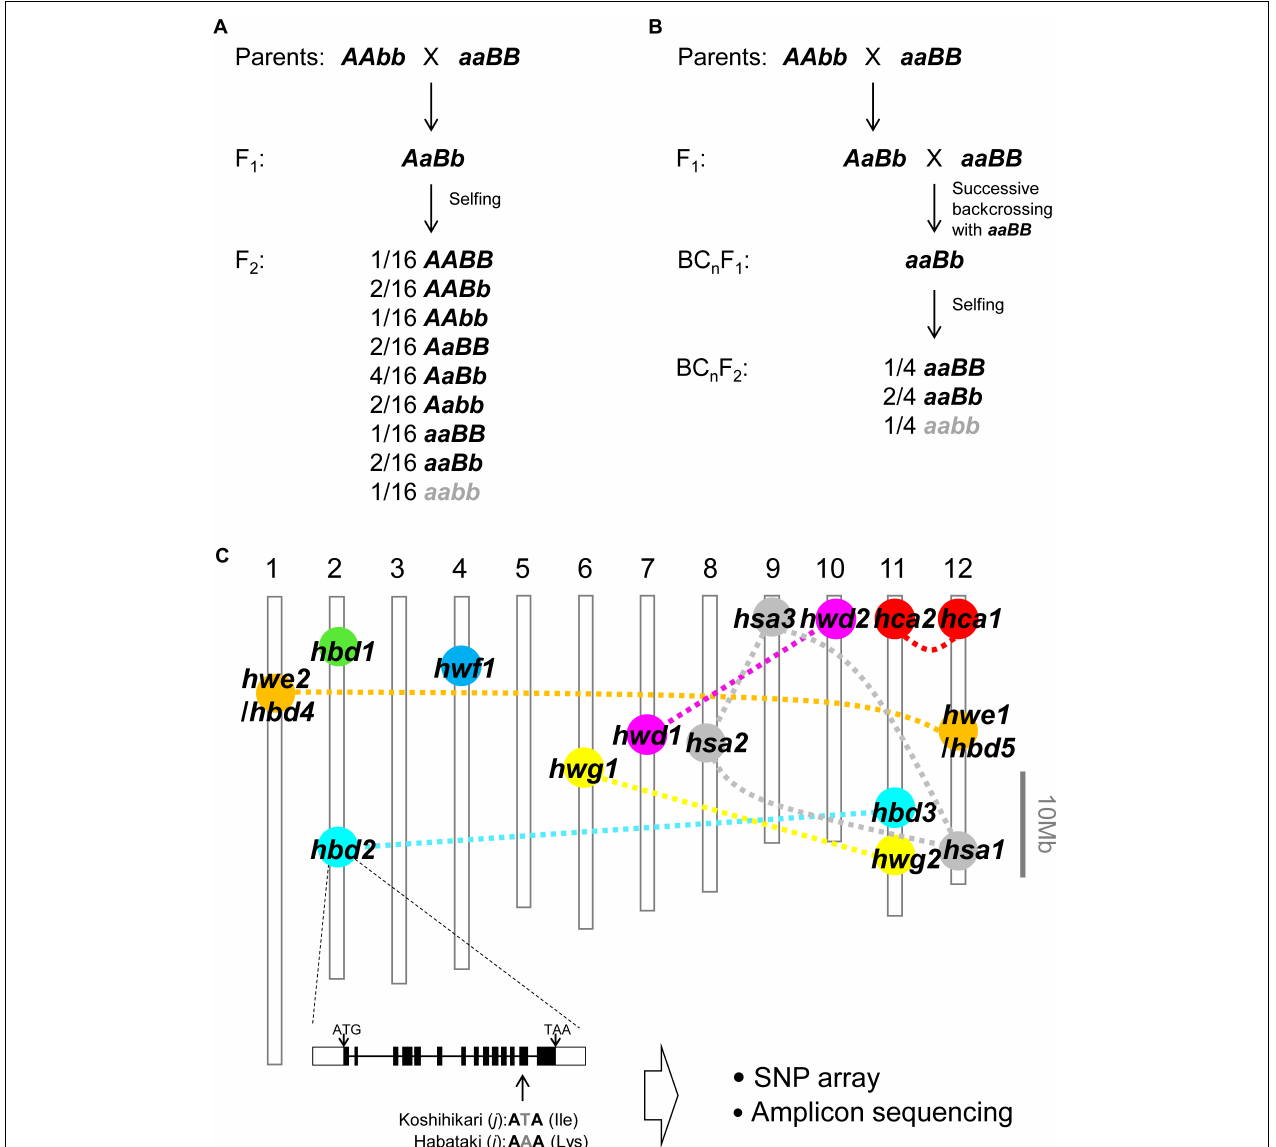
FIGURE 1 | The genetic basis of hybrid breakdown (HB). (A) Schematic representation of the HB genotype that segregates in the F 2 progeny. When the parental genotypes are AAbb and aaBB , 1/16 of the F 2 progeny without dominant allele, which is indicated by gray character (i.e., aabb ), show reduced viability and/or fertility, although the other genotypes are normal. In some rice crosses, the F 2 progeny with only one dominant allele (i.e., Aabb , aaBb ) also show reduced viability and/or fertility. (B) Schematic representation of the HB genotype that segregates in the BC n F 2 progeny. Further, 1/4 of the BC n F 2 progeny shows reduced viability and/or fertility. (C) Chromosomal location of genes underlying HB in rice crosses. The genes are roughly mapped based on the results of gene mapping in each study. A set of complementary genes are connected by the dotted line. Complementary genes with hbd1 and hwf1 have not been reported. The example of the functional nucleotide polymorphism causing HB published by Yamamoto et al. (2010) is shown, and this information will allow us to conduct a survey by SNP array or amplicon